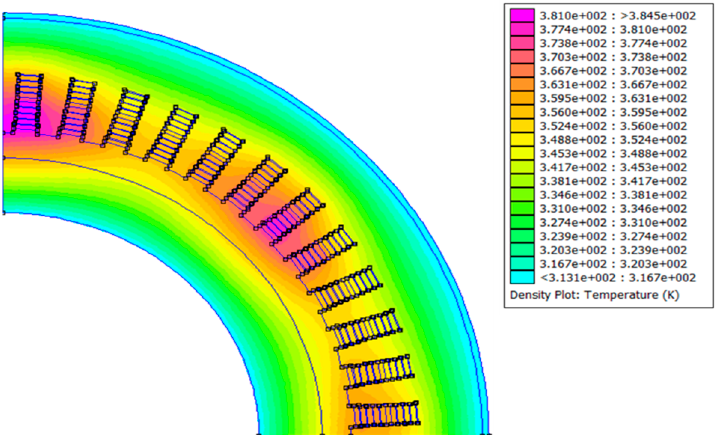
Figure 8 . Temperature inside a section of front-end windings of the optimum motor.